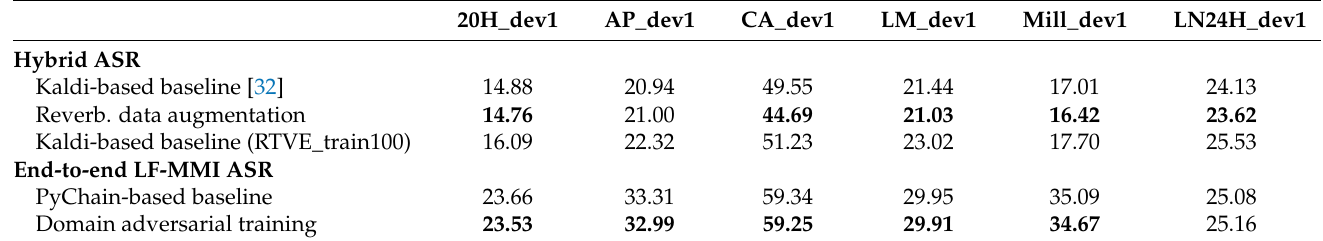
Table 2. WER (%) on the different datasets for hybrid and end-to-end ASR systems. Each one of the evaluation datasets contains one hour of speech. In bold, the improvements of the Kaldi-based system after applying reverberated data augmentation, and the improvements related to the Pychain-based system after applying DAT.